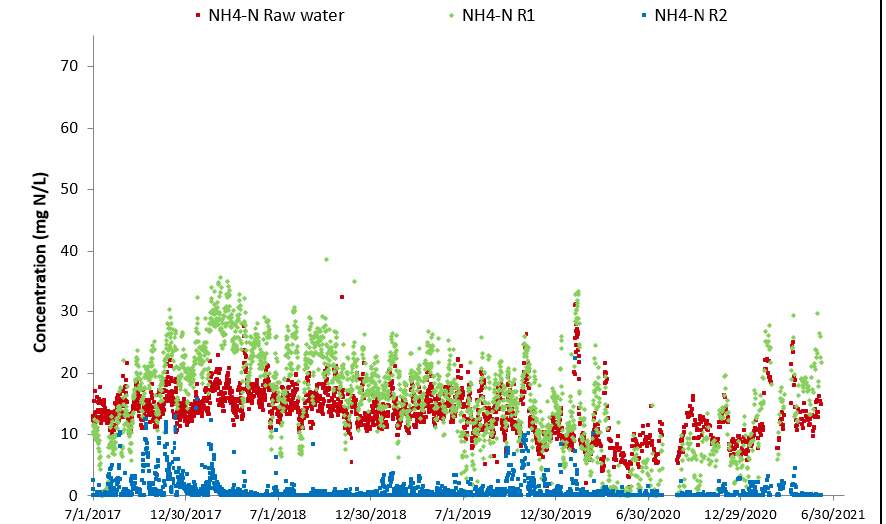
Figure 10. Evolution of NH 4 concentration across MBBR.